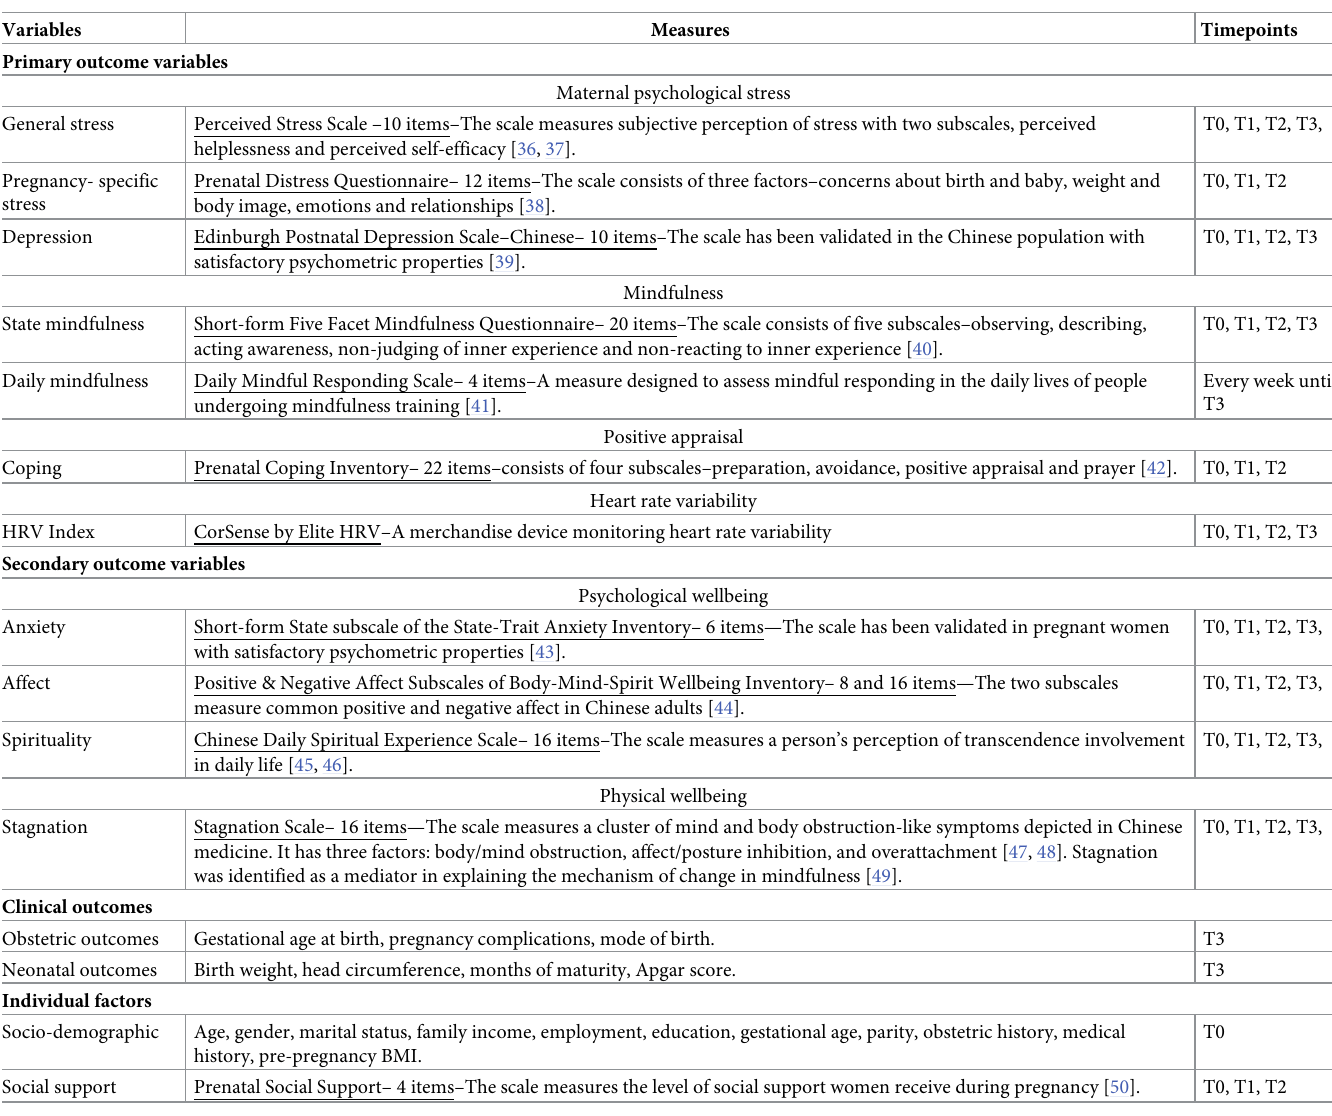
Table 1. Outcome